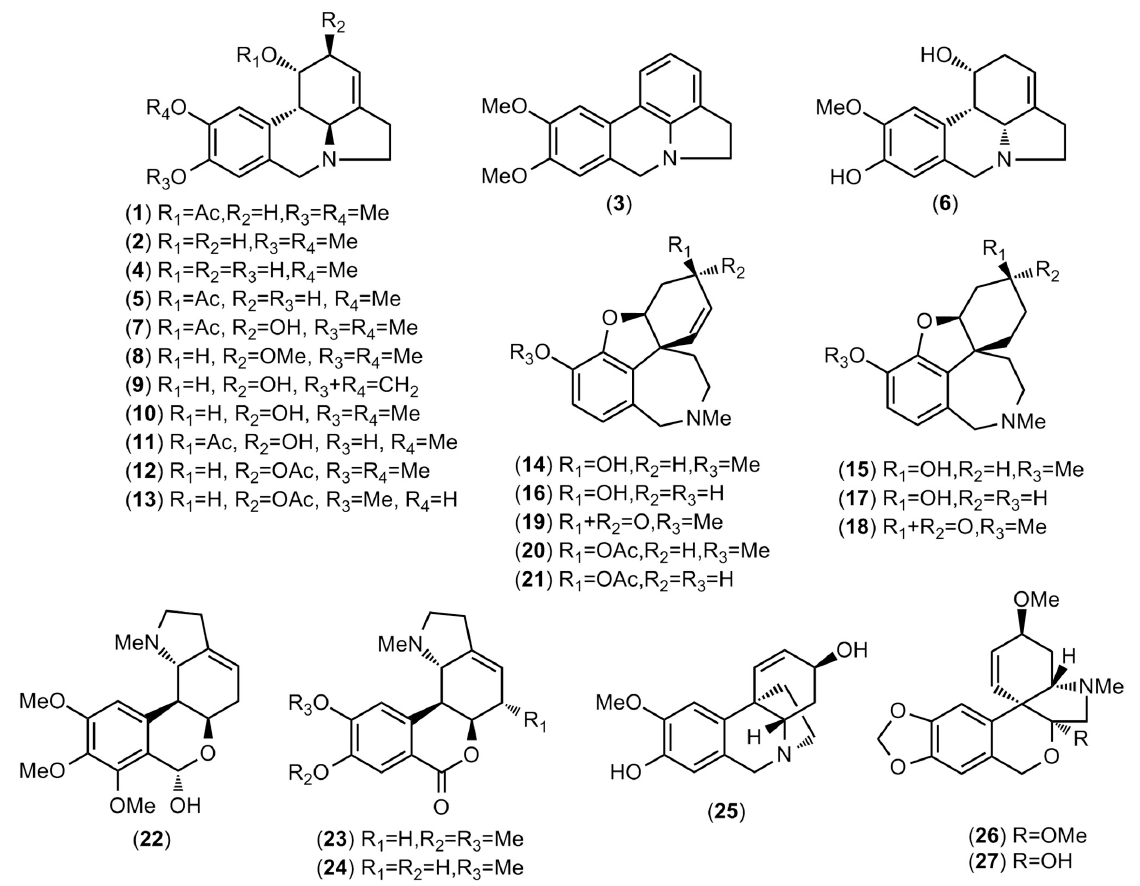
Figure 2. Alkaloids identified in Rauhia species by